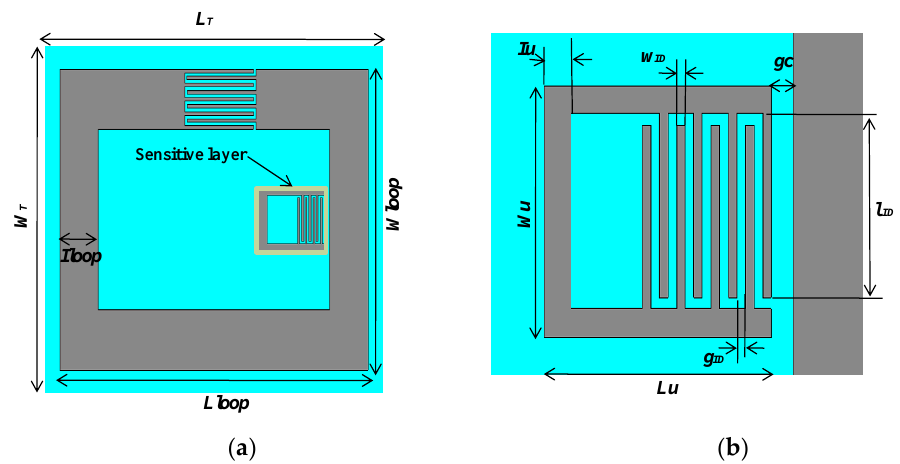
Figure 1. Layout of the proposed RFID chipless sensor: ( a ) IC-UD coupled inside the metallic loop; ( b ) resonant element. Blue — dielectric kapton substrate; grey — copper layer. Table 1. Dimensions of the sensor tag. TAG (Dimensions in mm)